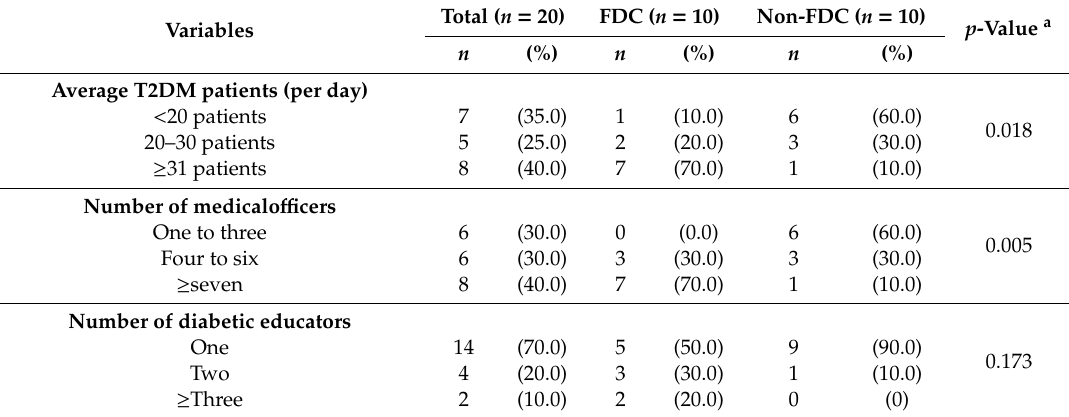
Table 2. Profile of primary health clinics in Kelantan ( n =